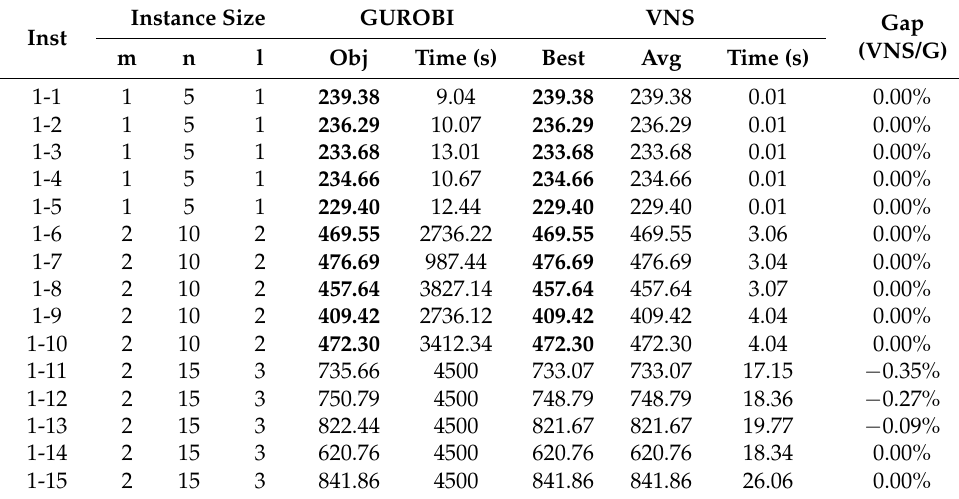
Table 3. Results for the small-sized